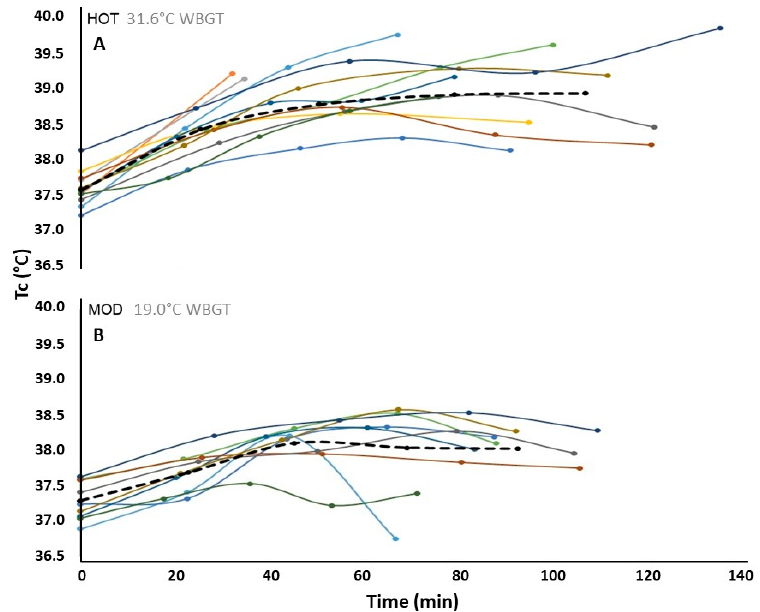
Figure 1. Individual (solid lines) and group average (dashed lines) core temperature (T c ) versus ( a ) HOT and ( b ) MOD hiking split time.